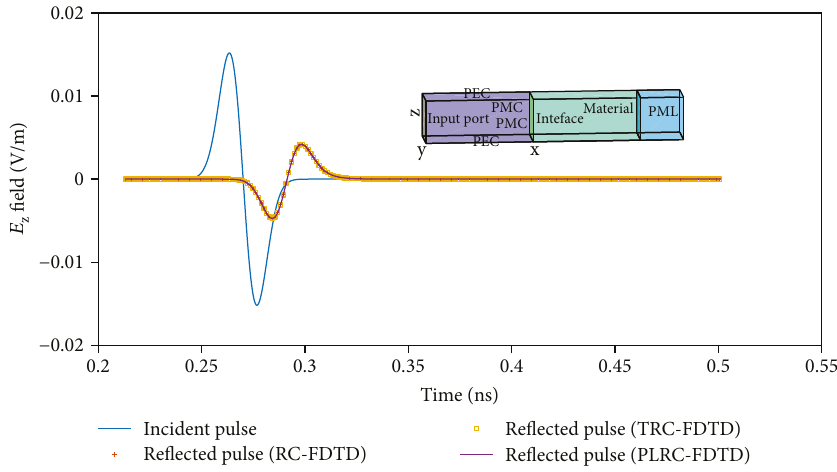
Figure 2: Plane wave normal incident on a vacuum/Debye model